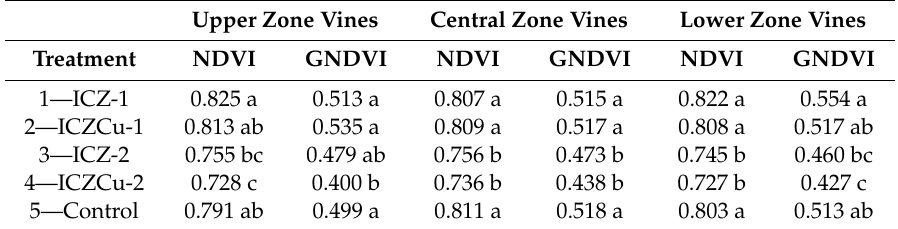
Table 4. Leaf reflectance measurements carried out on 19 September 2019 on vines treated with Italian chabasite-rich zeolitite and Italian copper chabasite-rich zeolitite (ICZ and ICZCu). Upper Zone Vines Central Zone Vines Lower Zone Vines Treatment NDVI GNDVI NDVI GNDVI NDVI